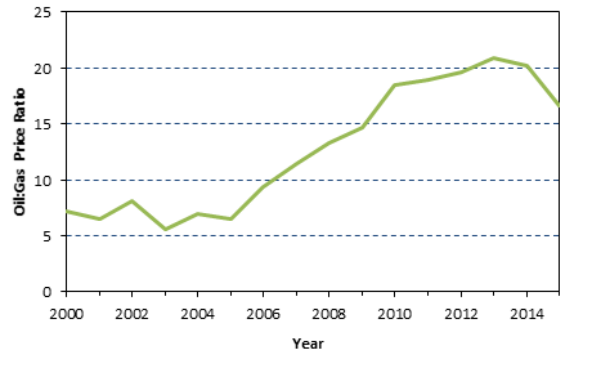
Figure 4: Average ratios of WTI crude oil ($/barrel) to natural gas prices ($/million Btu) Source: Salehi et al.